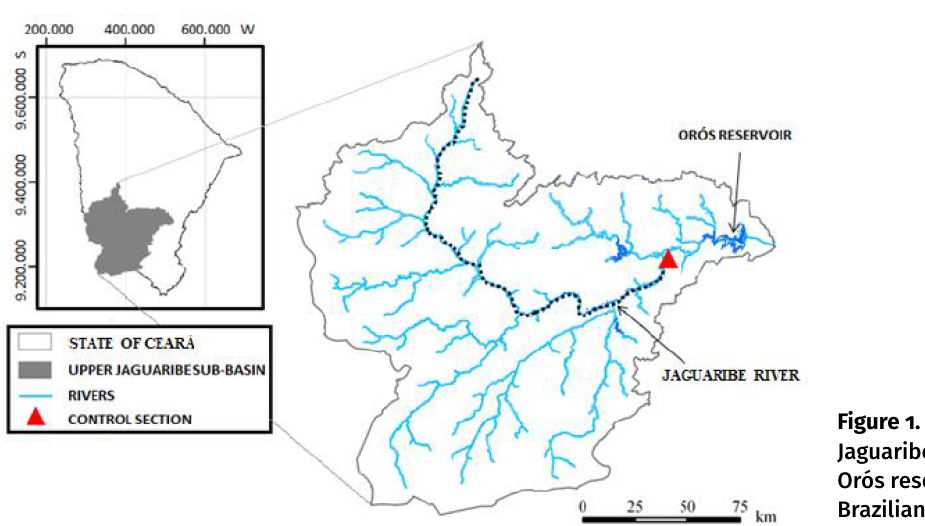
Figure 1. Location of the Upper Jaguaribe sub-basin and the Orós reservoir, State of Ceará, Brazilian semiarid